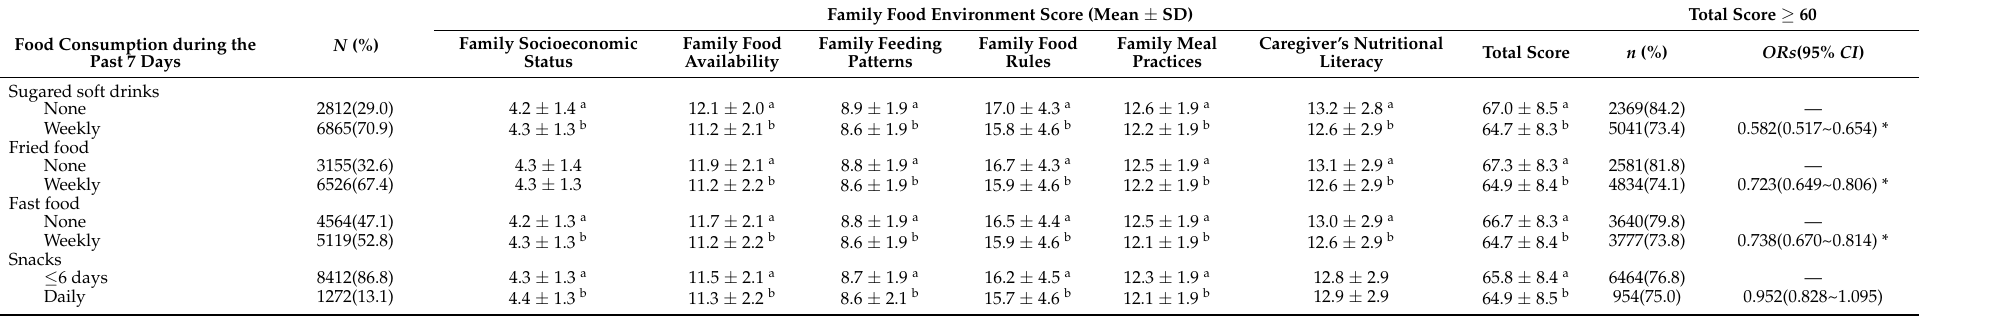
Table 4. Unhealthy food and snack consumption in relation to family food